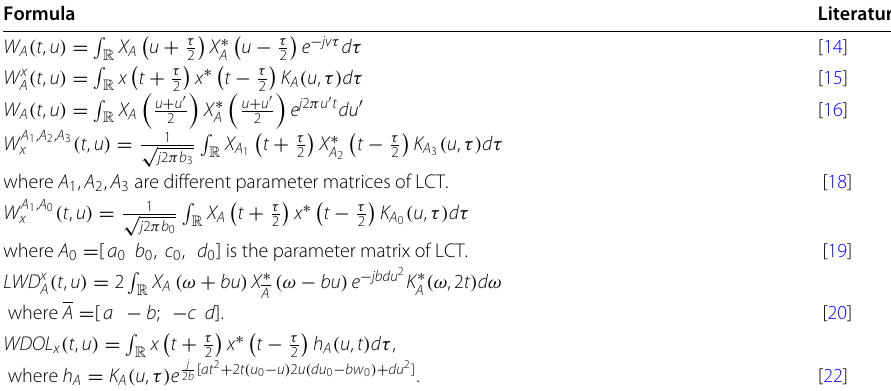
Table 2 Existing WVD associated with LCT Formula